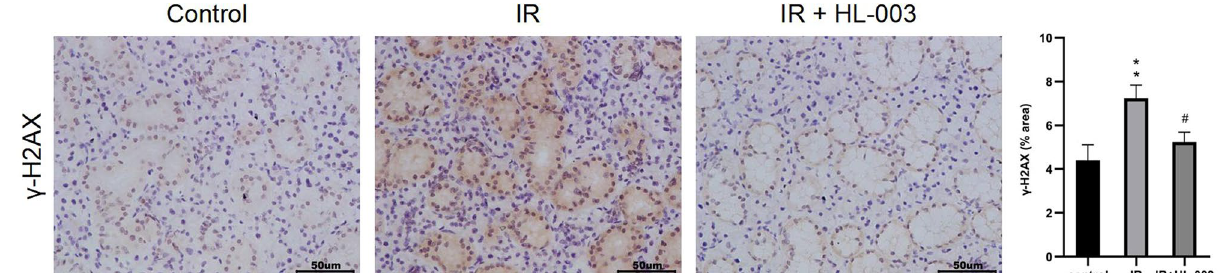
Figure 4. HL-003 protects salivary glands from IR-induced DNA damage. Immunohistochemical images of γ-H2AX are shown. Scale bars represent 50 μm. Each bar shows the mean ± SEM; **p < 0.01, compared with the control group; # p < 0.05, compared with the IR group (n = 6 per HL‑003 suppresses the apoptotic signaling pathway. TUNEL staining of salivary gland tissues was performed to detect apoptosis. Positive cells included acinar, ductal, and endothelial cells. The results showed that the number of apoptotic cells in the IR group was markedly higher than that in the control group (Fig. 5a,c). In contrast, the number of apoptotic cells was lower in the IR + HL-003 group than in the IR group.